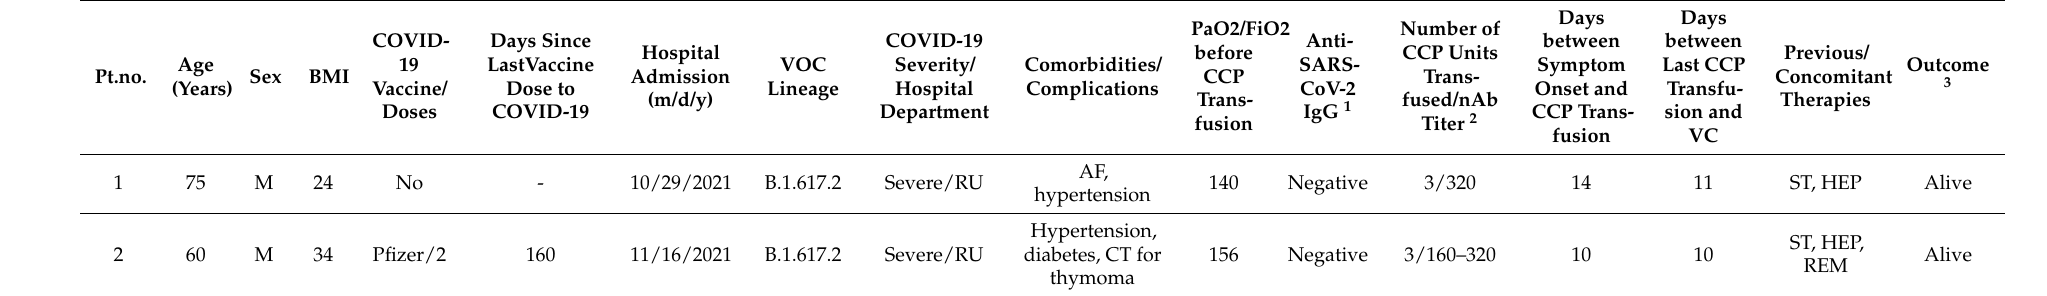
Table 2. Characteristics and outcome of COVID-19 patients receiving